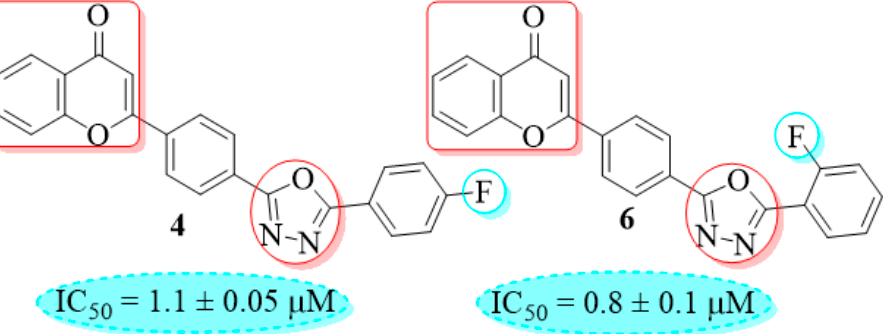
Figure 2. ortho -Fluoro and para -fluoro analogs (most potent